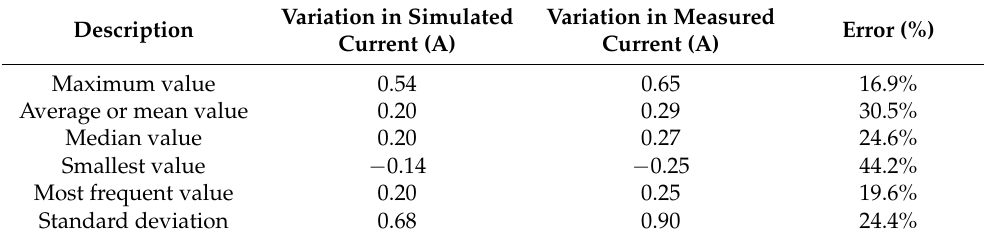
Table 11. Comparison between simulated and measured current—data statistics for motor